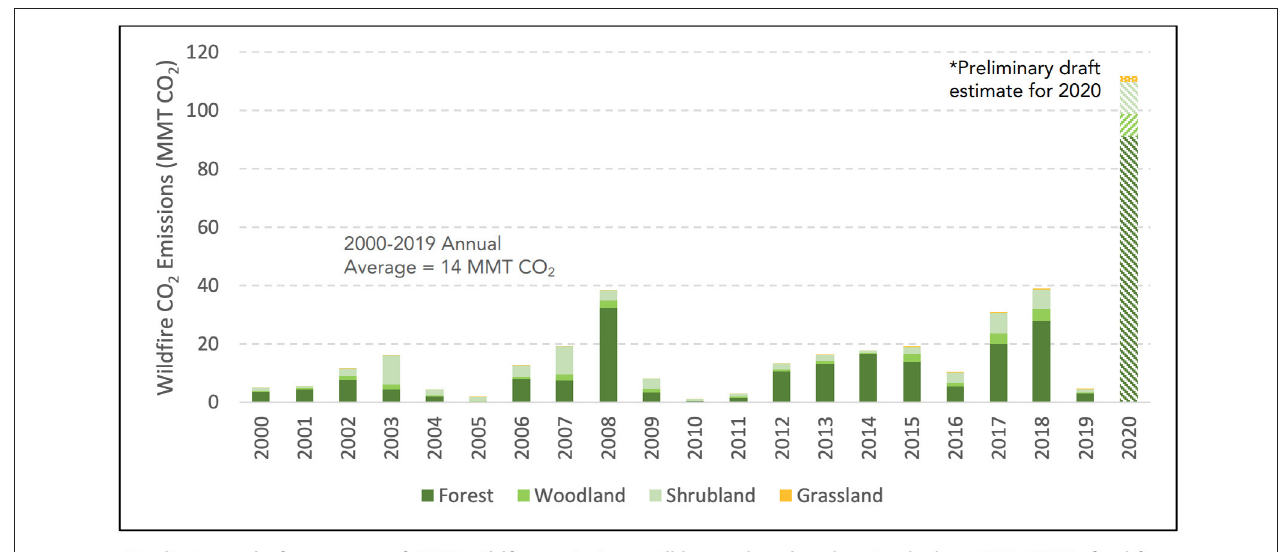
FIGURE 4 | Annual wildfire emissions in California (California Air Resources Board,